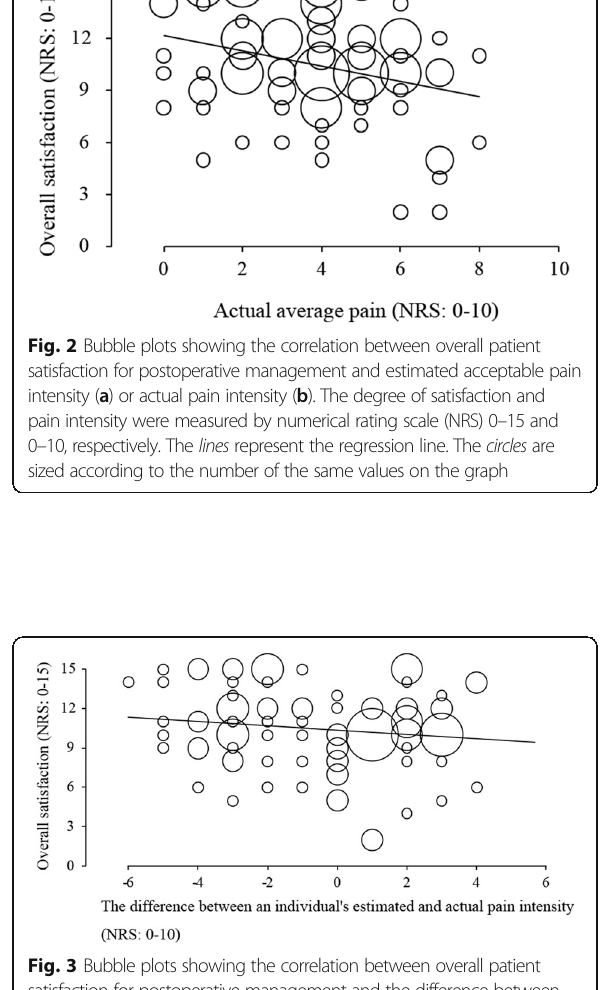
Fig. 3 Bubble plots showing the correlation between overall patient satisfaction for postoperative management and the difference between an individual ’ s estimated acceptable and actual NRS. The degree of satisfaction and pain intensity were measured by numerical rating scale (NRS) 0 – 15 and 0 – 10, respectively. The line represents the regression line. The circles are sized according to the number of the same values on the